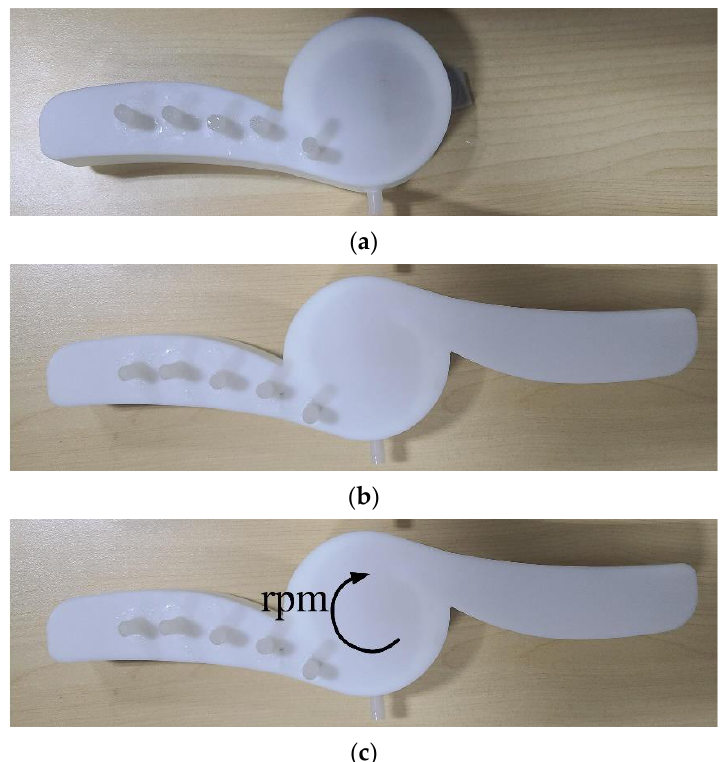
Figure 5. Pressure pulsation monitoring points positions.